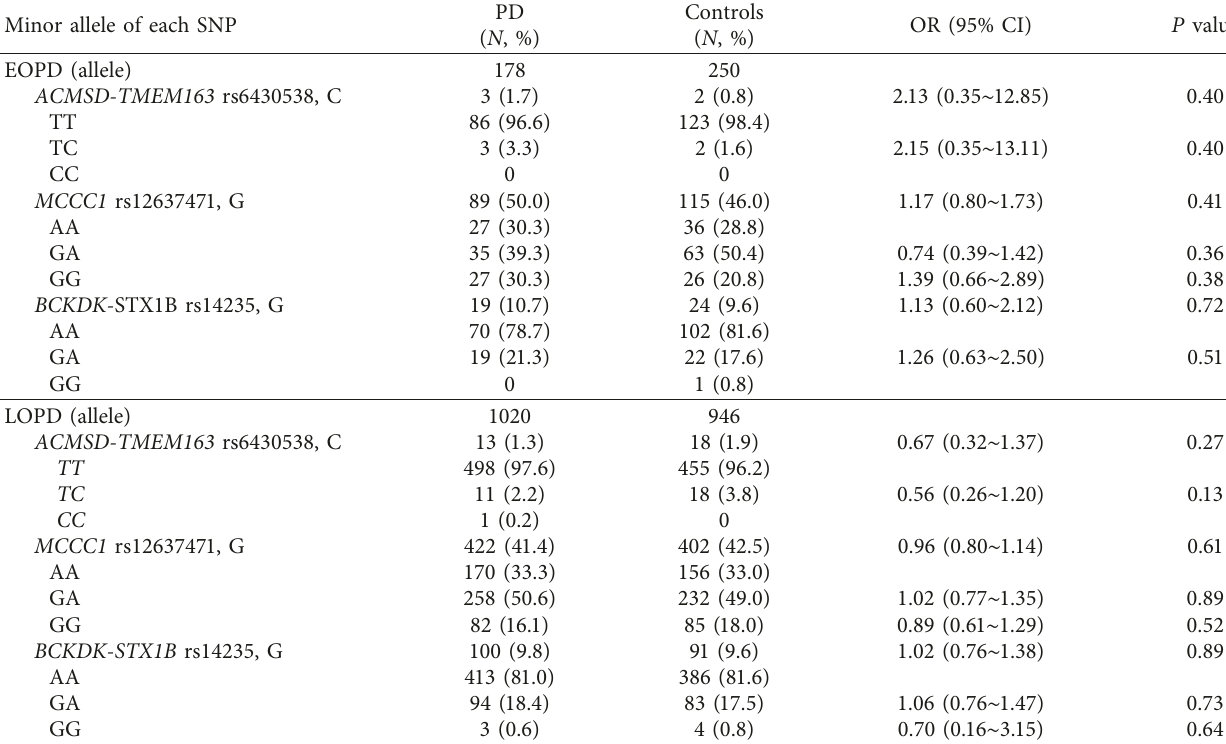
Table 5: Comparisons of minor allelic and genotypic frequencies of single nucleotide polymorphisms (SNPs) between early-onset Parkinson’s disease (EOPD) and late-onset Parkinson’s disease (LOPD) patients and the